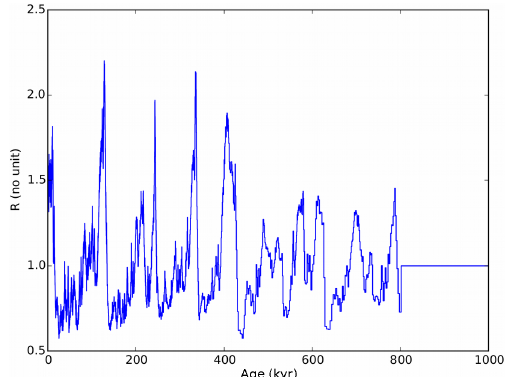
Figure 2. R(t) proportionality factor applied to accumulation and melting rates (see Eq. 2). The plot is cut at 1Myr for better read- ability. R(t) is based on the accumulation record at EDC for the last 800kyr (Bazin et al., 2013; Veres et al.,